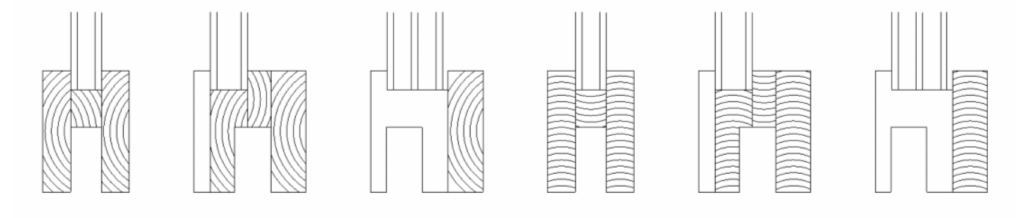
Figure 4. Conceptual drawing of window frames with a di ff erent sawn